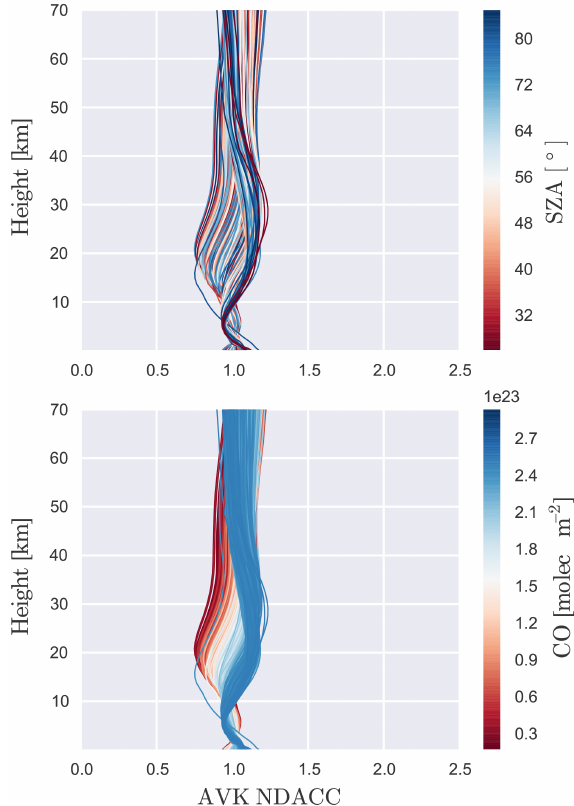
Figure 10. Column averaging kernels for the NDACC retrieval us- ing MIR spectra. Different solar zenith angles (SZA) are colour coded (upper panel). For a better visualization, column averaging kernels are depicted for different CO slant columns (lower panel).